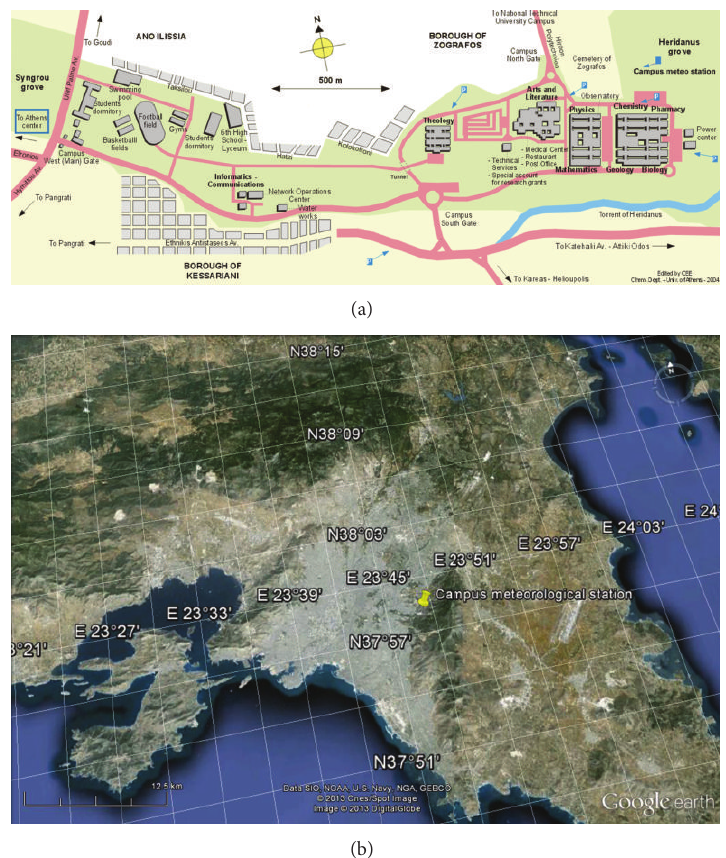
Figure 1: Athens University Campus (a) and satellite image of the wider Athens area (b) with the marked site of the campus meteorological station.